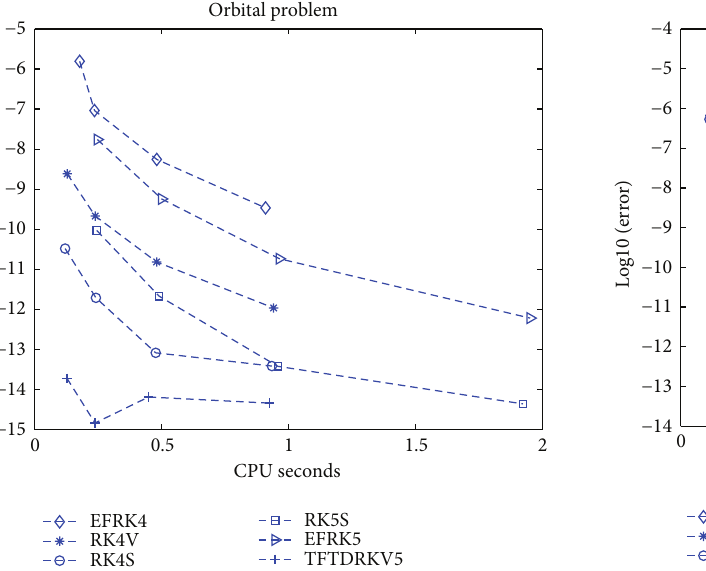
Figure 10: Efficiency curves for Problem